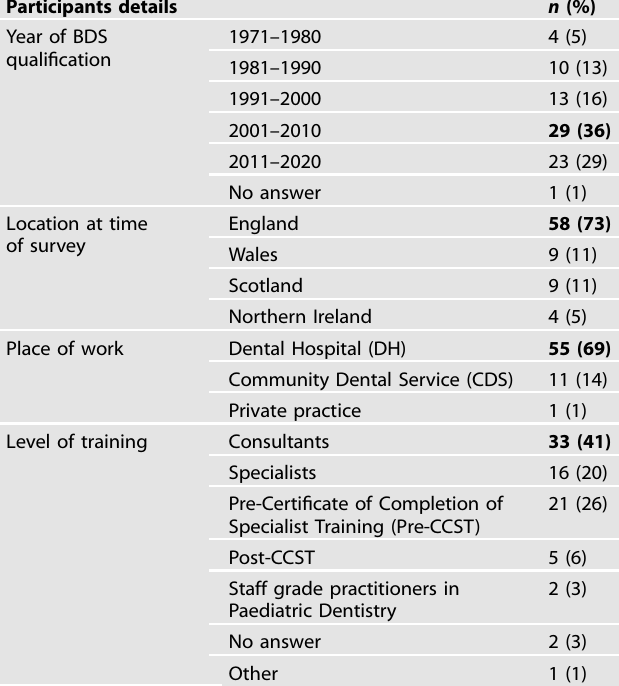
Table 2. Number and percentage of the participants ’ responses ( n = 80).